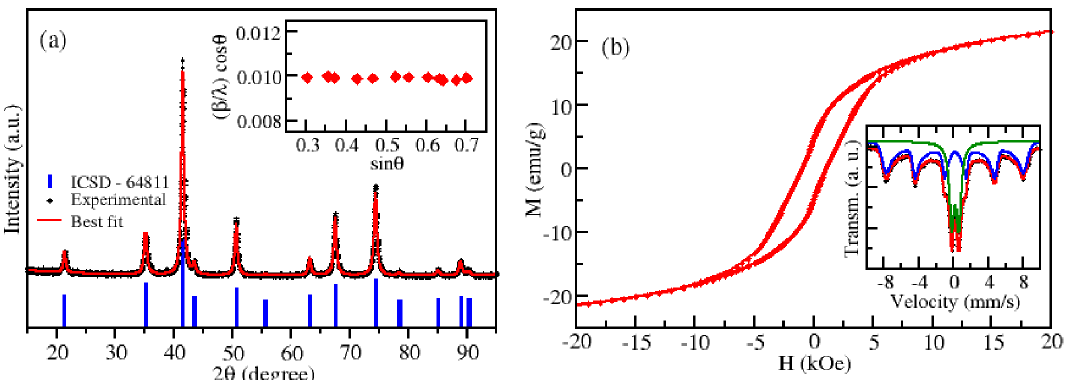
Figure 1. (a) X-ray diffraction pattern of a CFO sample. Dots and solid line are the experimental data and best fit respectively. Bars represent the ICSD-64811 standard pattern. Inset : Williamson-Hall curve. (b) Room temperature hysteresis loop of a CFO sample. Inset : Mössbauer spectrum of a CFO sample. Dots and solid line are the experimental data and best fit respectively.